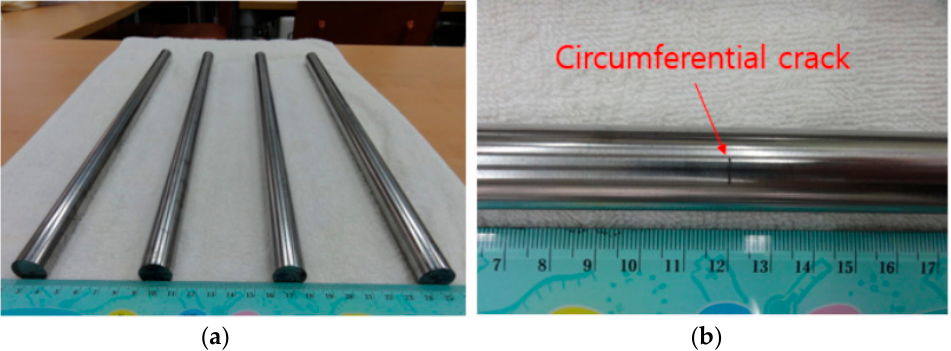
Figure 4. Samples with artificial defects. ( a ) Overall samples ( b ) An example with Circum crack.